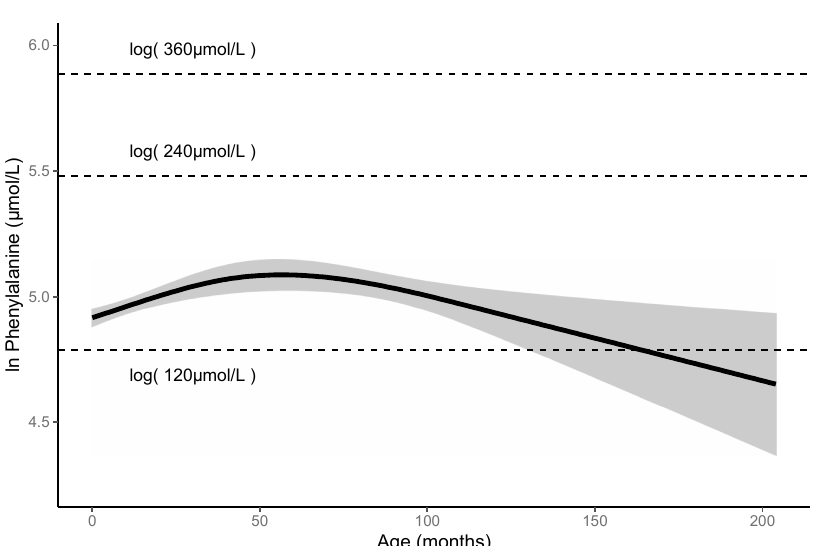
Figure 3. Predicted Phe levels until 200-month-olds are less than 360 µ mol/L in patients with HPA carrying p.R53H.